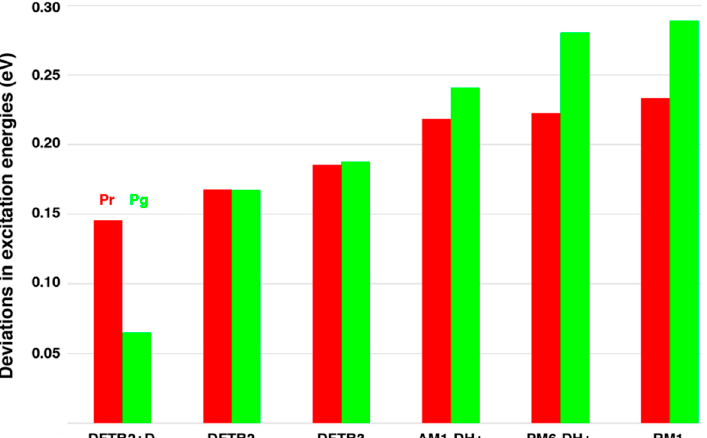
Figure 1. Deviations of the excitation energies for the first excited state based on differently optimized structures for QM42. The energies are calculated via the RI-CC2/cc-pVDZ level of theory for P g (green) and P r (red). The reference values from RI-CC2/cc-pVDZ optimizations are 2.01 eV and 2.00 eV for P r and P g , respectively, see also Tables S5 and S6.